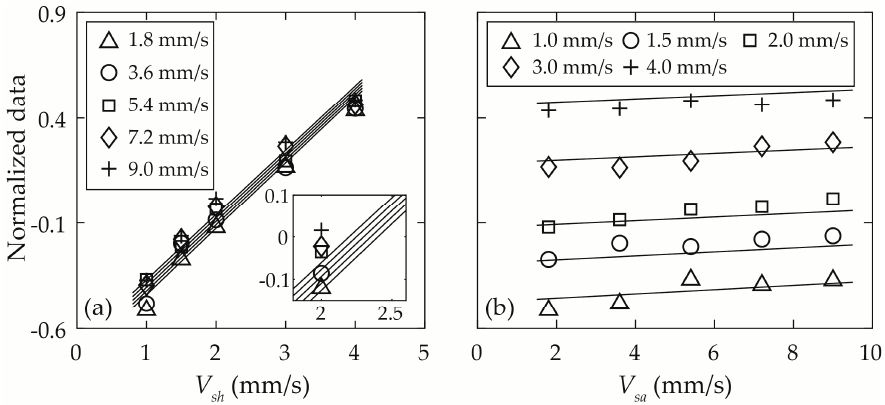
Figure 10. Normalized smear length L s ′ (the points with different marker styles) and normalized particle velocity V p ″ (the solid lines) as a function of ( a ) sheath flow velocity V sh at five different sample flow velocities V sa , and ( b ) V sa at five different V sh . Table 8. The fitted coefficients of L s ’ and V p ″ versus sheath flow velocity V sh at five different sample flow velocities V sa .